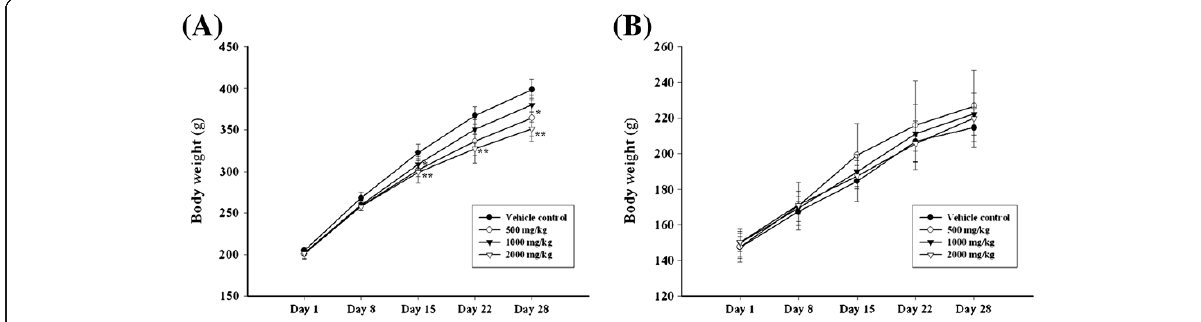
Figure 1 Body weight changes of male and female rat treated with SST for 4-weeks. ( A ) body weight changes of males, ( B ) body weight changes of female. * , ** Indicate a significant differences at P < 0.05 and P < 0.01 levels, respectively, when compared with the vehicle control group.